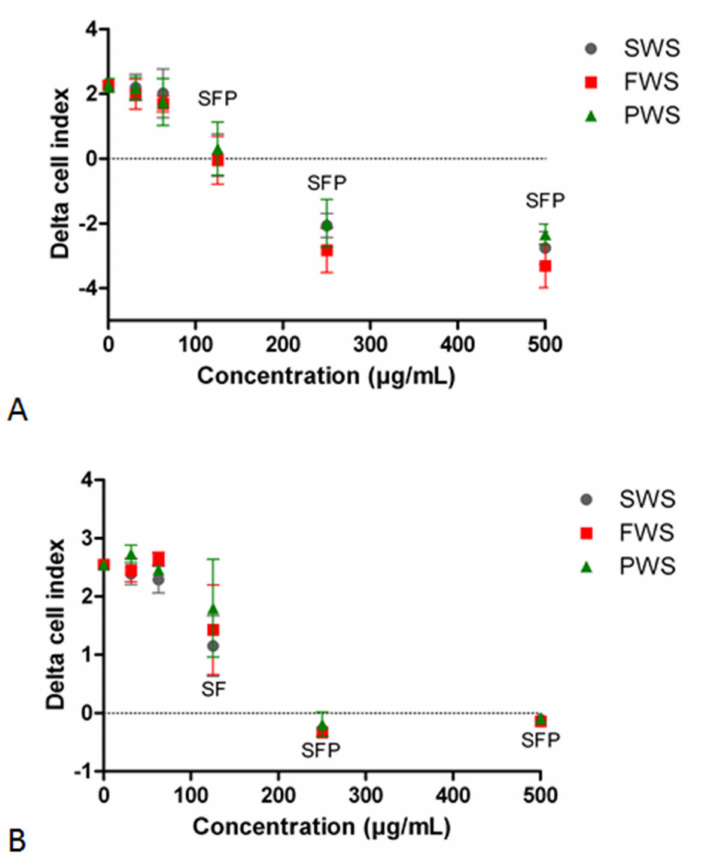
Figure 2. Delta cell index of A549 cells. ( A ): Delta cell index for the time of treatment with increasing concentrations of three types of water-soluble particulate pollutants from biomass burning: flaming (FWS), smoldering (SWS), and pyrolysis (PWS). ( B ): Delta cell index for the time of wash-out after removal of water-soluble particulate pollutants from biomass burning. Means of three independent experiments are presented. Significant differences at p ≤ 0.05 between the particles and the control are represented by F for FWS, S for SWS, and P for